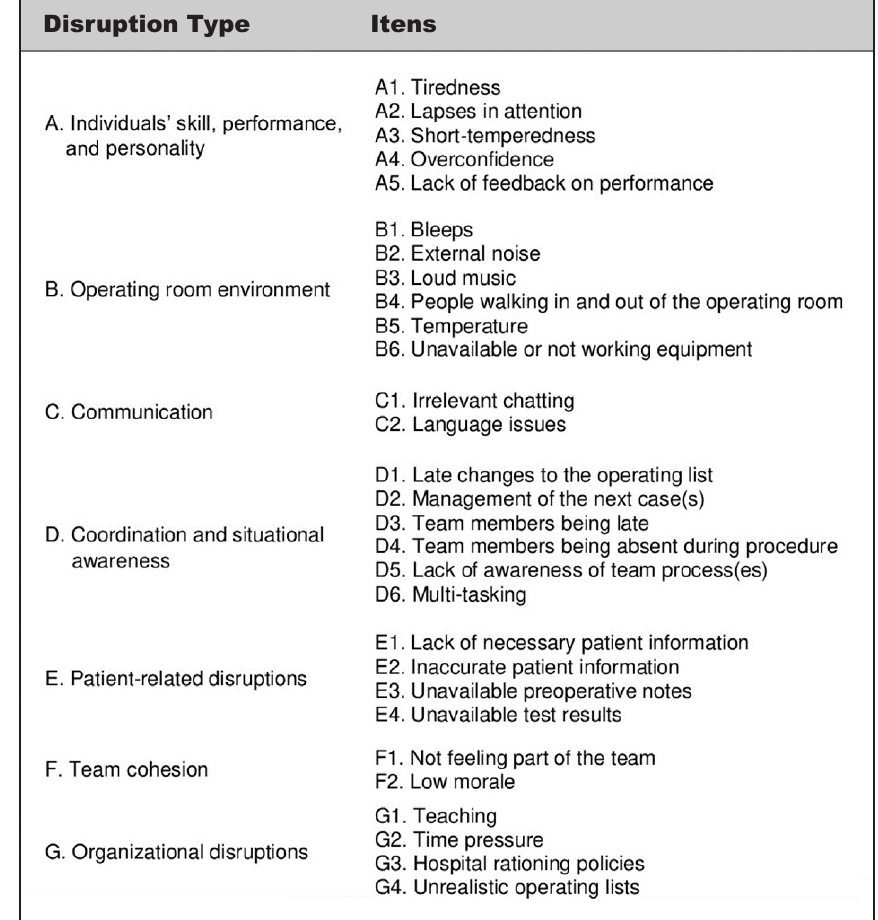
Fig. 1 - Disruptions in Surgery Index